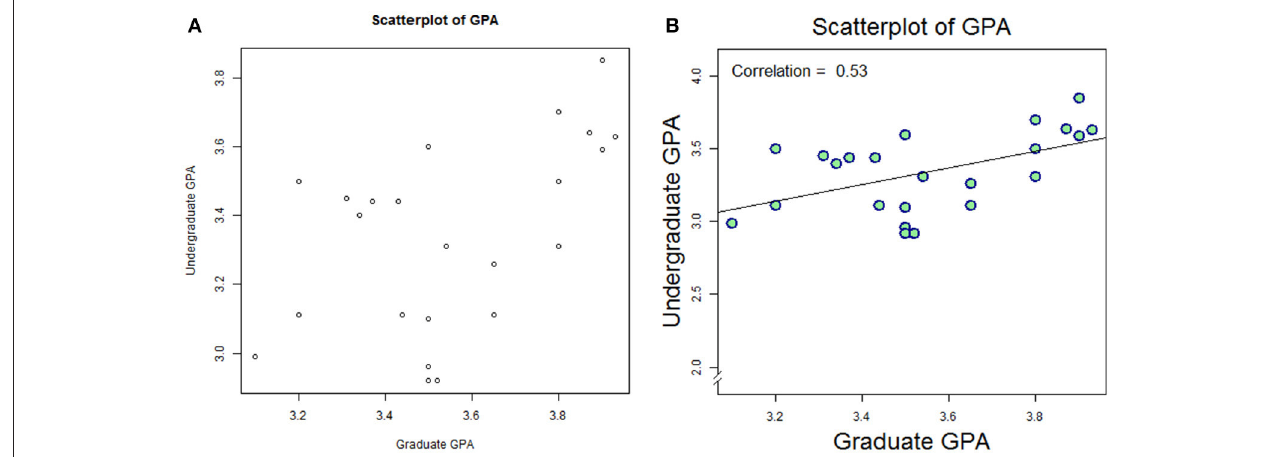
FIGURE 2 | Default plot (A) and modified plot (B) depicting scatter of relationship between undergraduate GPA and graduate GPA.